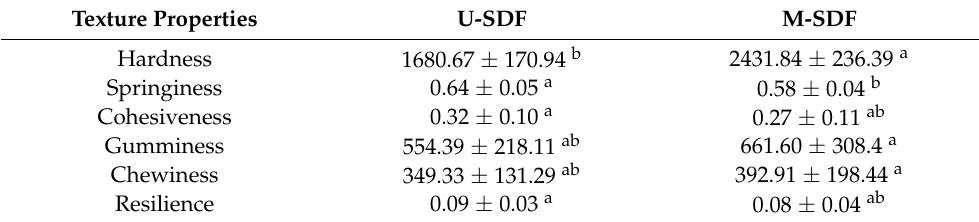
Table 3. Texture properties of jelly containing U-SDF or M-SDF.